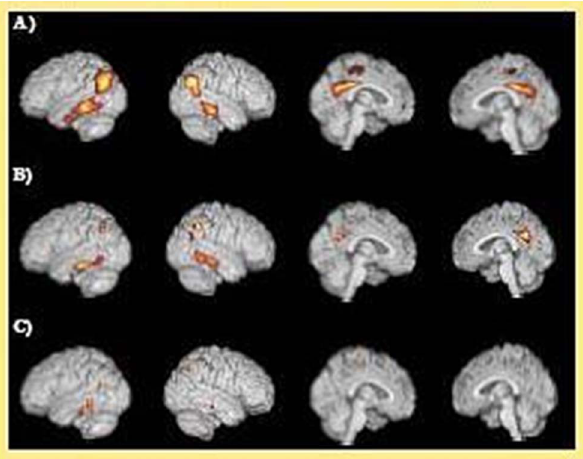
Figure 2. HCI z-score maps of AD-associated hypometabolism in a APOE e 4 homozygote (A), a APOE e 4 heterozygote (B) and a APOE e 4 non-carrier (C) demonstrate differences in extent of hypometabolism proportional to APOE e 4 gene dose.